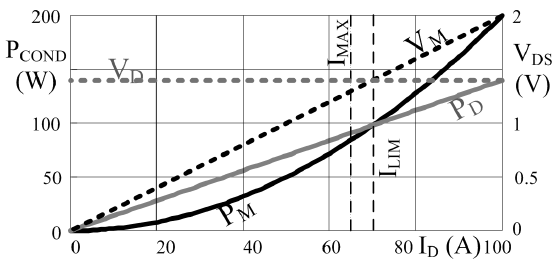
Figure 6. Drain-to-source voltage ( V DS , dashed lines) and conduction losses ( P COND , filled lines) for both diode conduction (gray) and MOSFET conduction (black), for the half-bridge current-source (HBCS) prototype.